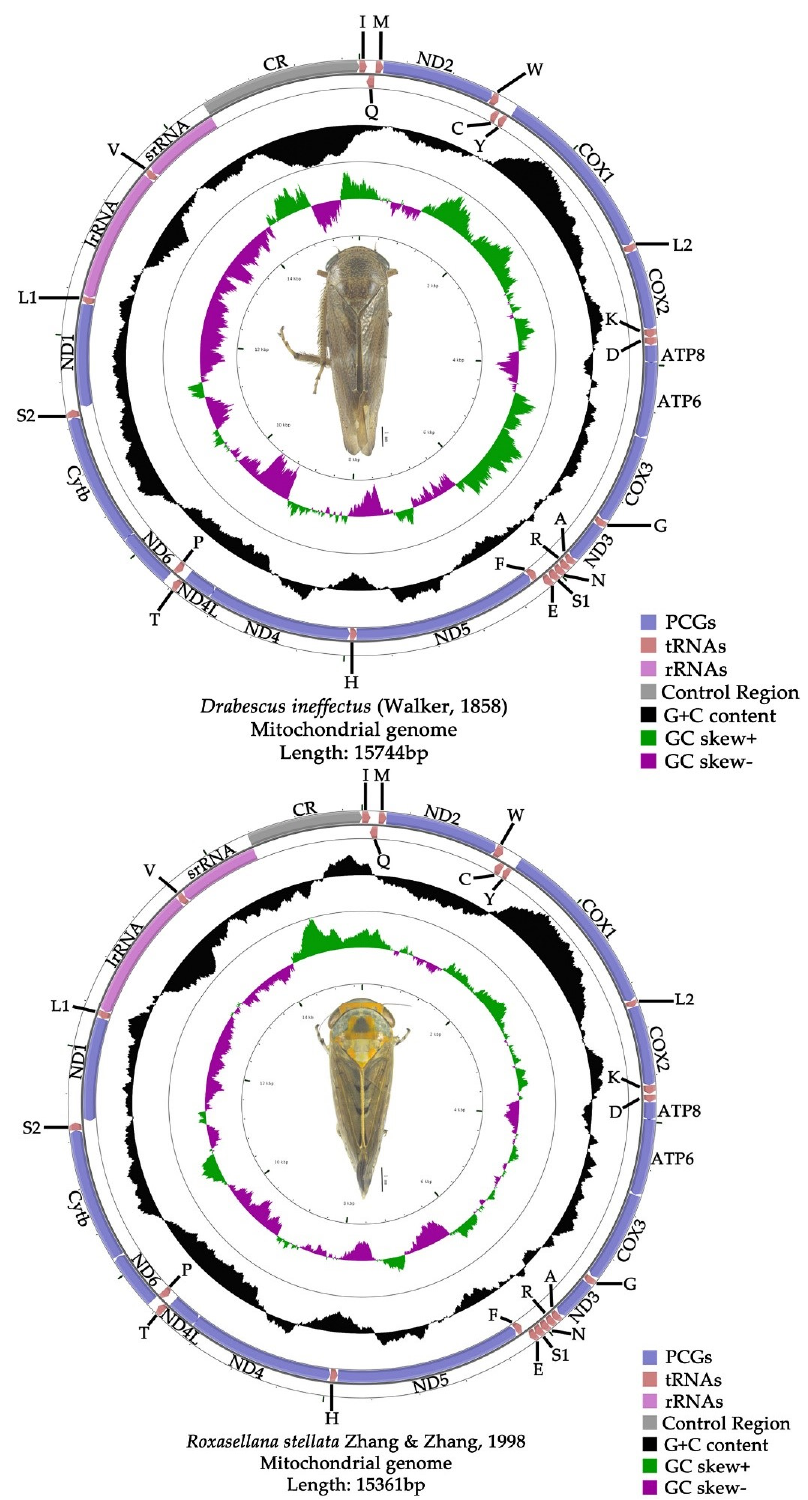
ff ectus and Roxasellana